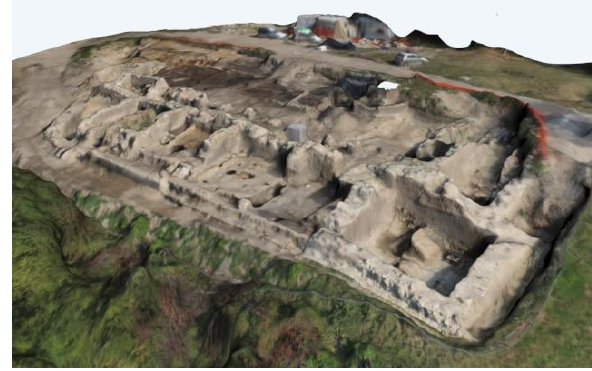
Figure 7. Textured digital surface model of the ruins